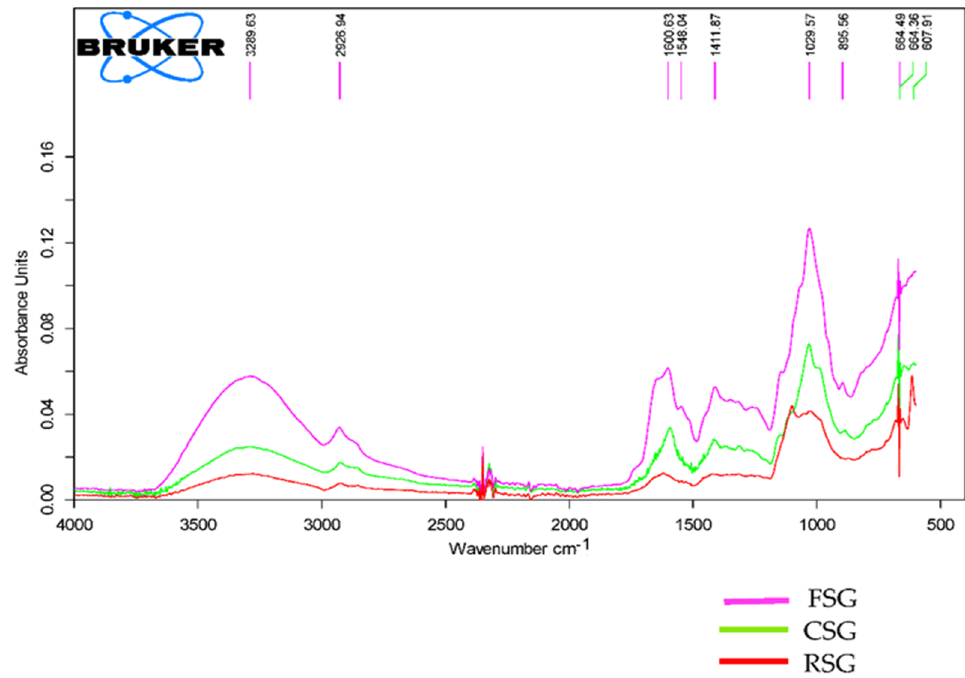
Figure 1. FTIR spectra of the FSG (Flaxseed byproduct gum), CSG (Chia seed byproduct gum), and RSG (Rocket seed byproduct gum) in the spectral region between 400 and 4000 cm − 1 .